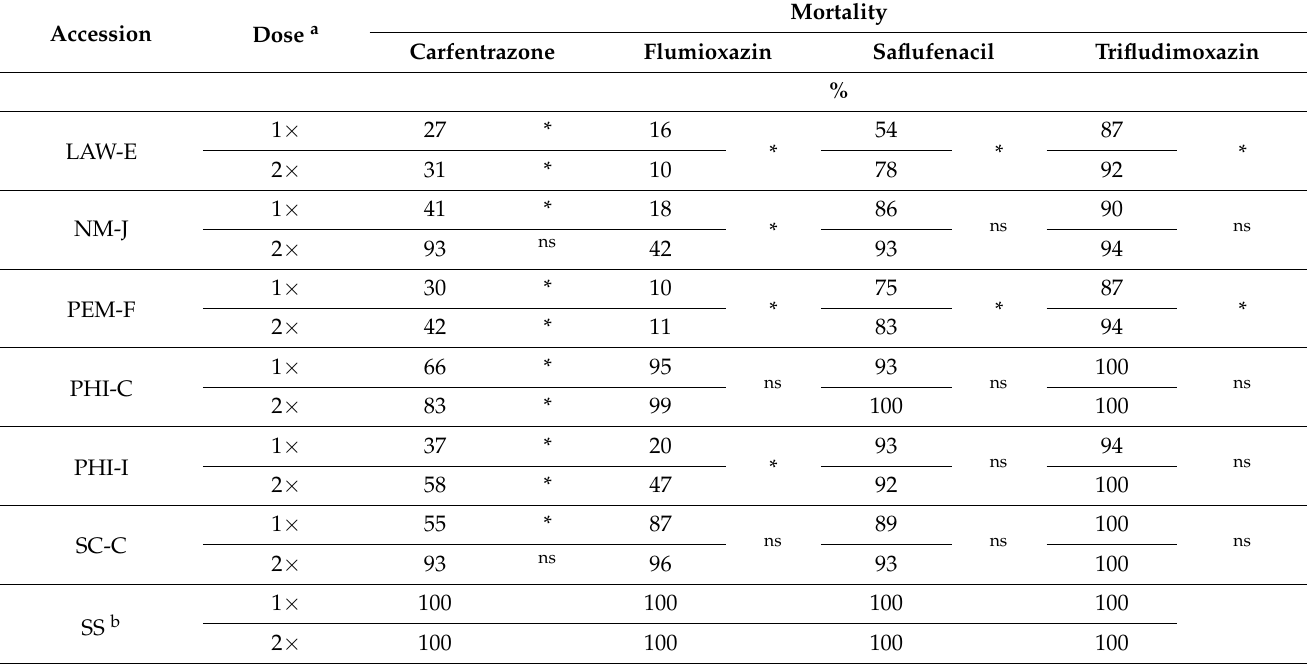
Table 4. Response of fomesafen-resistant Amaranthus palmeri accessions to the 1 × and 2 × rates of PPO-inhibiting herbicides, Altheimer Laboratory, University of Arkansas, Fayetteville, USA 2020.